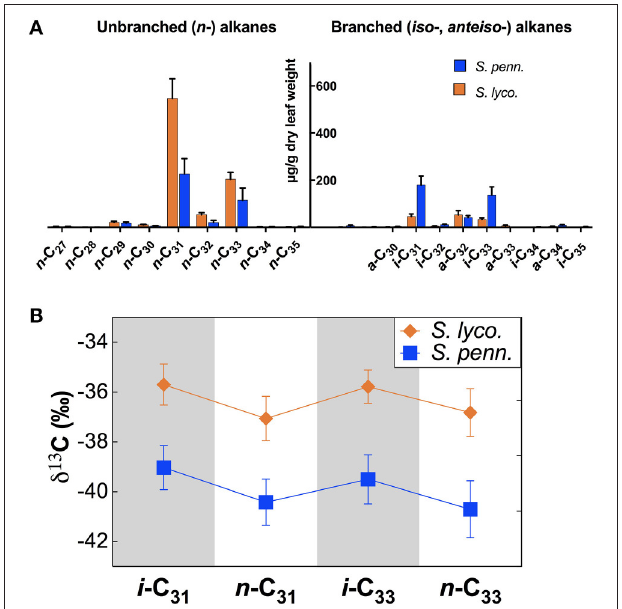
FIGURE 2 | Leaf waxes from S. lycopersicum cv M82 and S. pennellii . (A) Average concentration of leaf wax molecules across ten biological replicates normalized to leaf mass, with unbranched (i.e., normal , left) and branched (i.e., iso - and anteiso- , right) alkanes. S. pennellii (blue) contains greater amounts of iso -alkanes than S. lycopersicum cv M82 (orange). Error bars indicate one standard deviation of the mean. (B) Carbon isotope values ( δ 13 C) of n - and iso -alkanes from the most abundant chain lengths (C 31 and C 33 ) of S. pennellii (blue) and cv M82 (orange). The pattern of iso - over n -alkane enrichment is consistent between both species. Additionally, δ 13 C values from S. pennellii (blue) are consistently depleted relative to those from S. lycopersicum cv M82 (orange). Data are from 10 biological replicates analyzed in triplicate; analytical uncertainty ± 0.2 ‰ . Error bars represent standard deviation of biological replicates.